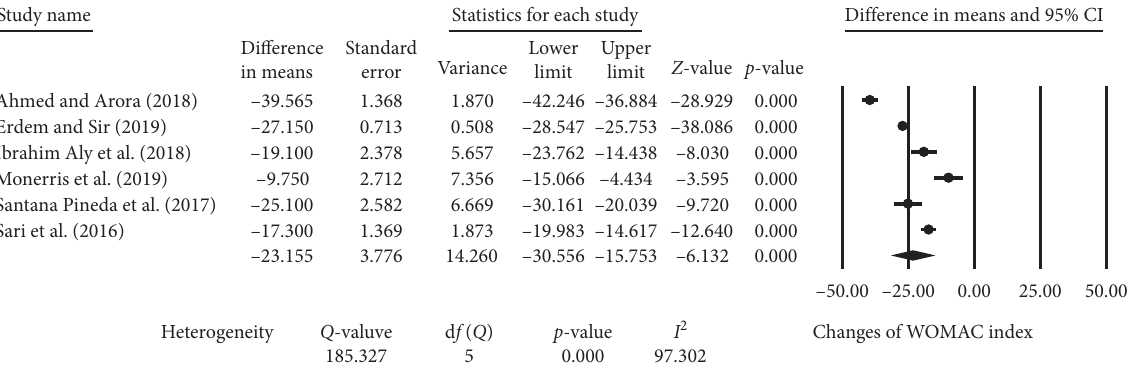
Figure 3: Percentage (%) of the risk of bias in the randomized controlled trials (RCTs) of ultrasound-guided radiofrequency (RF) in the treatment of patients with knee osteoarthritis (KOA).